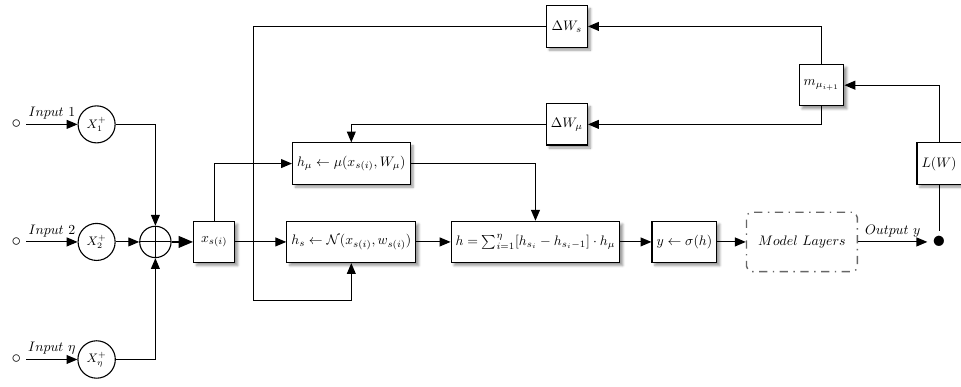
Figure 2. Neurofuzzy aggregation layer